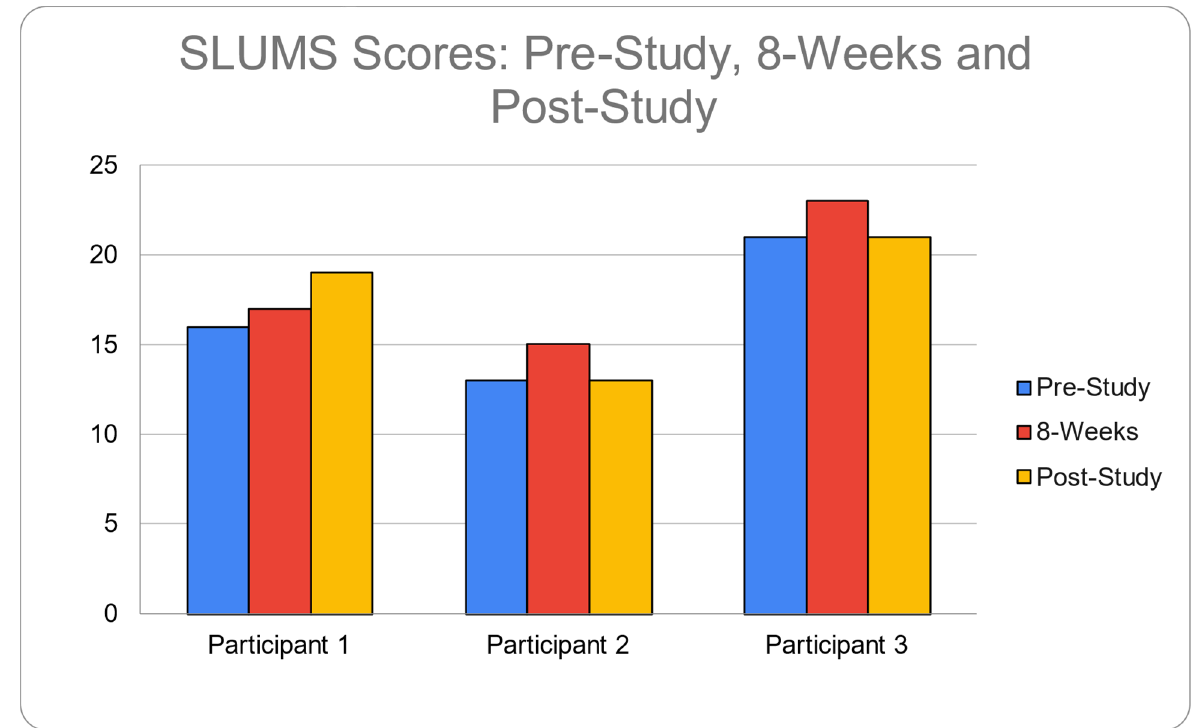
Figure 1. SLUMS Scores for 3 Cases.